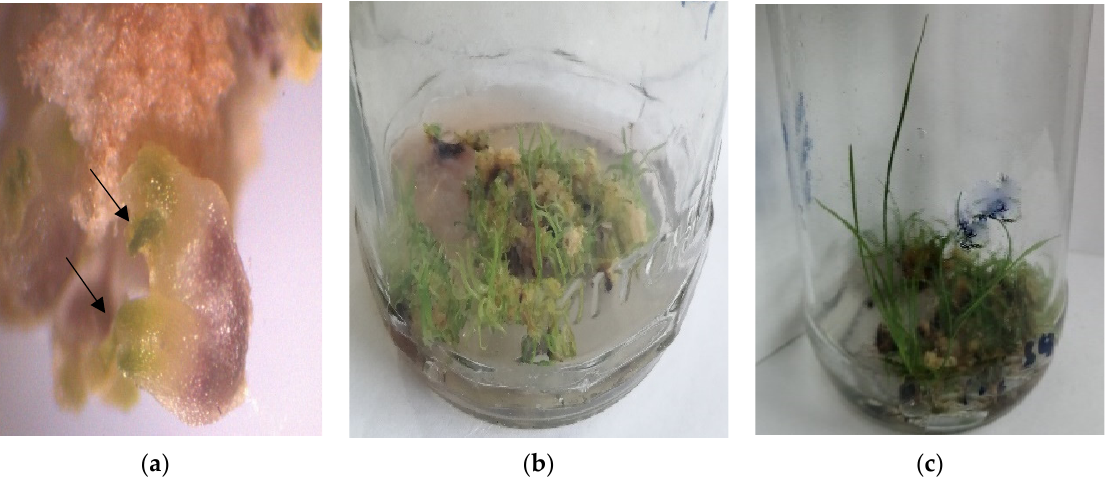
Figure 10. ( a ) Stereomicrograph showing shoot induction (arrows) from callus culture in CP-77-400 on MS + 5 mgL − 1 2,4-D (20×), ( b ) shoot induction in callus of CP-77-400 on MS + 1 mgL − 1 BAP after 10 days, and ( c ) shoot induction in callus of CP-77-400 on MS + 1 mgL − 1 BAP after 20 days of inoculation (2×).